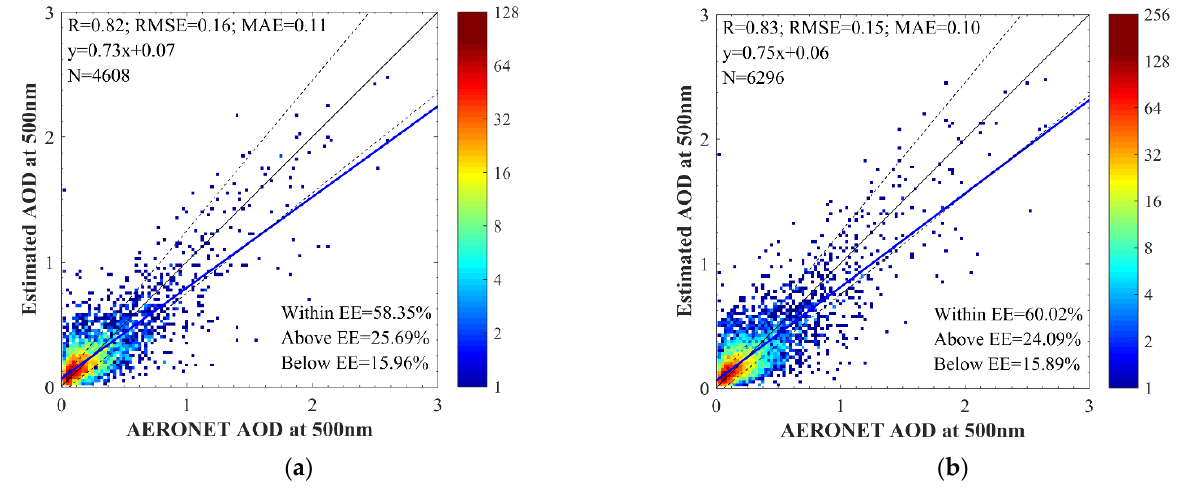
Figure 6. Leave-one-station-out cross-validation results of the collocated samples by averaging the AERONET AOD observations within ( a ) 5 min and ( b ) 15 min of the Landsat-8 overpass. The DNN method is not to replace the existing radiative transfer methods, but to